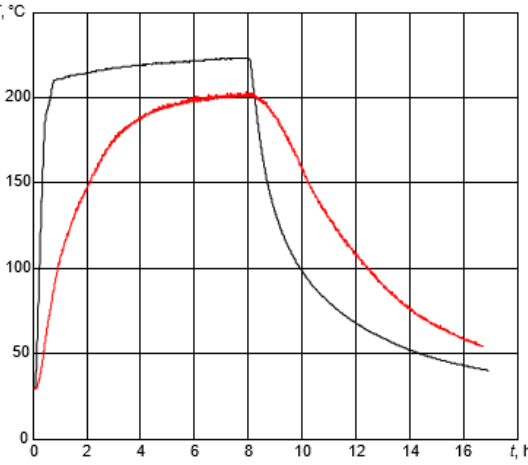
Figure 7. A thermal test of the developed ultrasonic transducer at 25–225 °C. Black: the temperature inside the drying oven; red: the temperature of the sample.